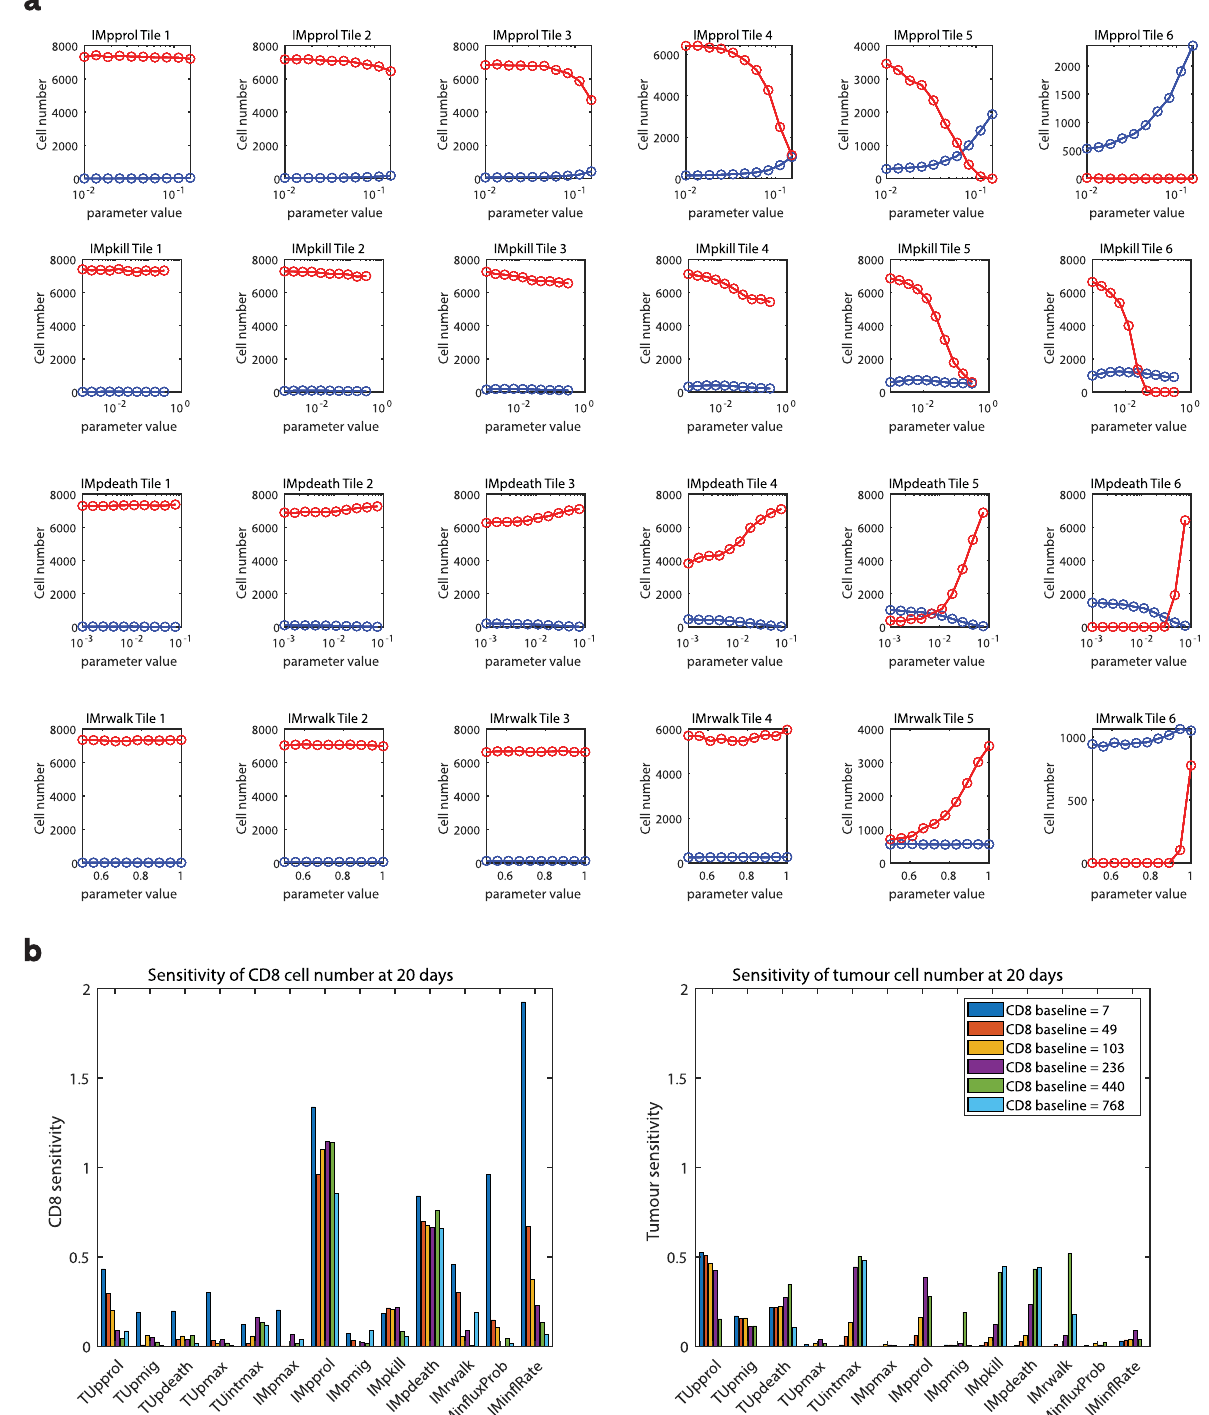
Fig. 3 Sensitivity analysis. a For six hand-selected tiles re fl ecting different CD8 numbers and distributions at baseline, and four model parameters, the numbers of CD8 and tumour cells at the 20-day time point are recorded for the range of parameter values scanned. CD8 number is shown in blue and the tumour cell number is shown in red. b Summary plot of the sensitivity of 13 model parameters that govern the behaviours of CD8 and tumour cells. The sensitivity was calculated as the change in cell count across the parameter range at day 20 divided by the parameter range scanned. CD8 sensitivity is shown on the left and tumour cell sensitivity is shown on the to address some of the challenges faced in clinical trials, namely model has been optimised and tested quantitatively using a novel the scheduling of on-treatment biopsies. We view this model as a spatial agreement measure and accurately (mean accuracy 77%) tool to inform the human decision-maker for biopsy scheduling, predicts the spatiotemporal distribution of cytotoxic CD8 + T cells perhaps revealing some hidden features that may in fl uence their in tumour tissue. These results encourage us to apply this model